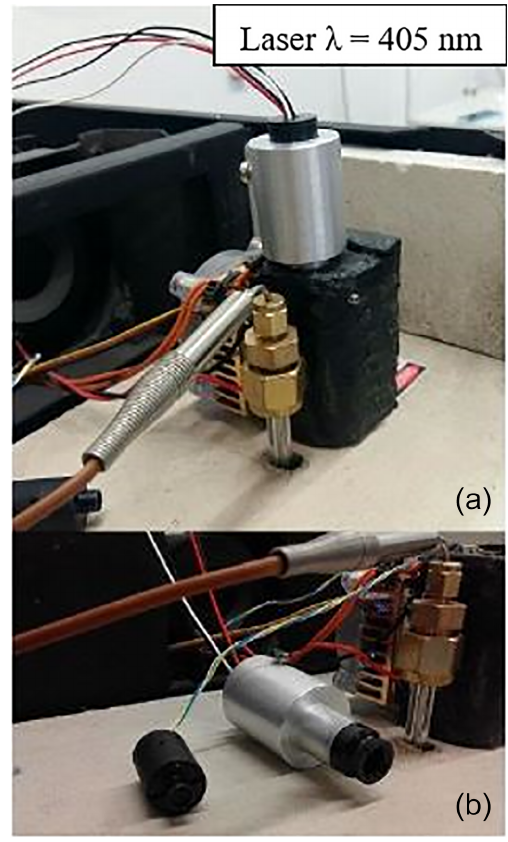
Figure 1. The new λ = 405nm laser diode mounted by a steel adapter on the Sunset furnace (a) and comparison with the standard λ = 635nm laser diode implemented by the manufacturer (b)